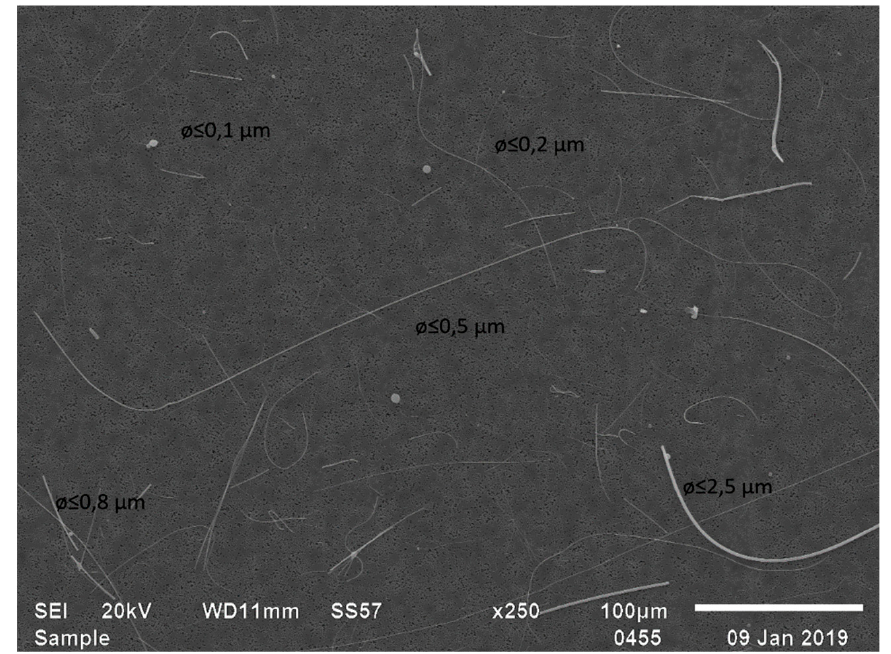
Figure 4. SEM image of fibers derived from Camfil F7 ventilation filters for incoming air, Camfil Svenska AB,